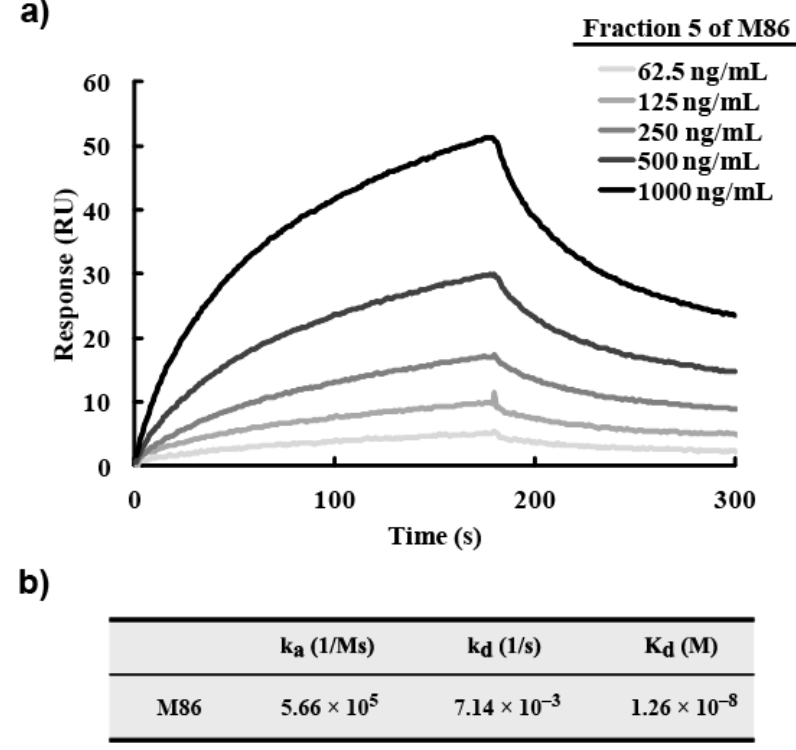
Figure 6. SPR analysis for M86. ( a ) SPR sensorgram recordings for the association and dissociation of M86. Morphine-C-Tg (20 µg/mL) was immobilized on CM5 sensor chips as described in Experimental Section 3.10. The protein concentration of fraction 5 was indicated. ( b ) Summary. The protein concentration of morphine-C-Tg-binding M86 (1st and 2nd bands of fraction 5: see Figure 2b-3) was estimated to be 59% by densitometric analysis (ImageJ) and used to estimate the K according to 1:1 binding